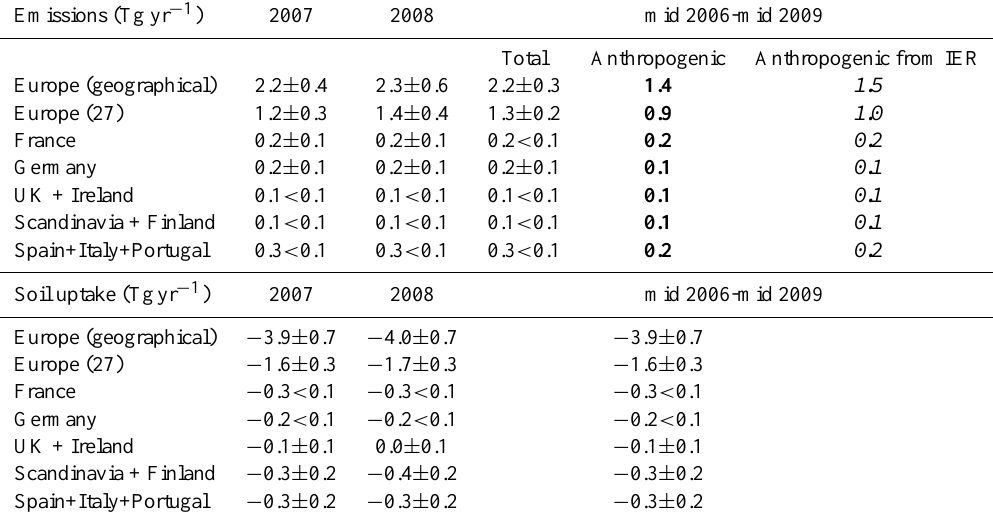
Table 5. H 2 budget per country in Europe in Tg yr − 1 . The indicated error represents the maximum spread of the scenarios S1 to S4 compared to S5 for the emissions and of the scenarios S2 to S4 compared to S5 for the soil uptake as the soil uptake is not inverted in scenario S1. In bold, the anthropogenic emissions from S5. In italics, the anthropogenic emissions from IER. (Thiruchittampalam and K¨oble,